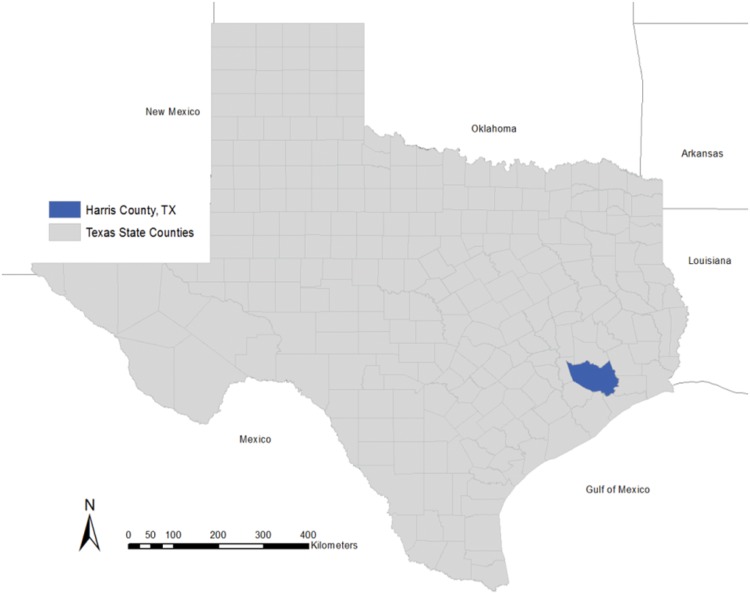
Harris County, Texas